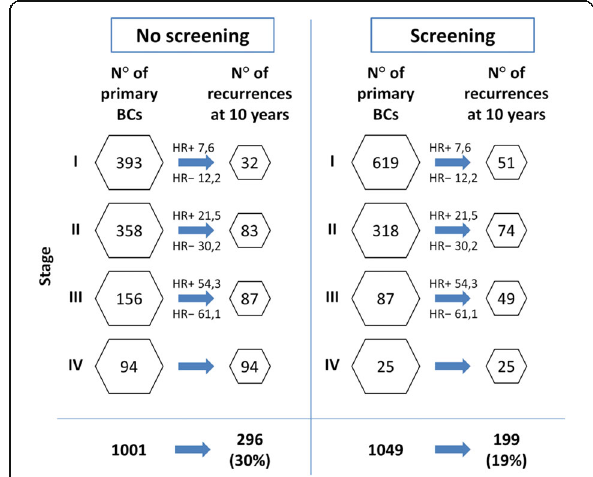
Fig. 2 Effect of screening and chemotherapy on breast cancer recurrences among women aged 60 to 74 years, diagnosed with breast cancer between 1992 and 1999. Stage distribution was derived from Puliti et al. [21] considering attenders and non- attenders to screening mammography; 5% overdiagnosis attributed to screening mammography is taken into account. HR+ and HR − recurrences are back-calculated from Mariotto et al. [24]. The worst scenario reflects the absence of mammography screening and the use of chemotherapy alone. BCs, breast cancers; HR+, hormone receptor-positive breast cancers; HR − , hormone receptor-negative breast